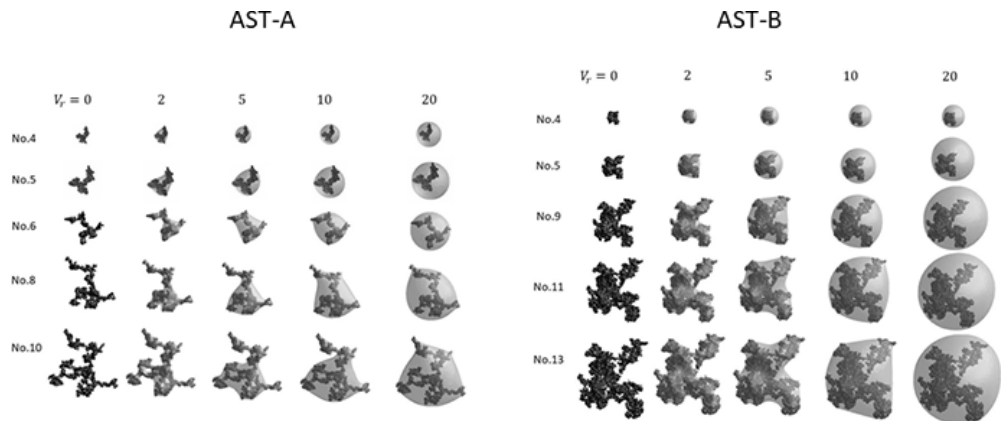
Figure 4. Mixed soot particle model developed using artificial surface tension (AST) for the attached water-soluble material. Several Type A (Type B) aggregates of different sizes were used on the left (right) side. The marching cubes method was applied for surface rendering.